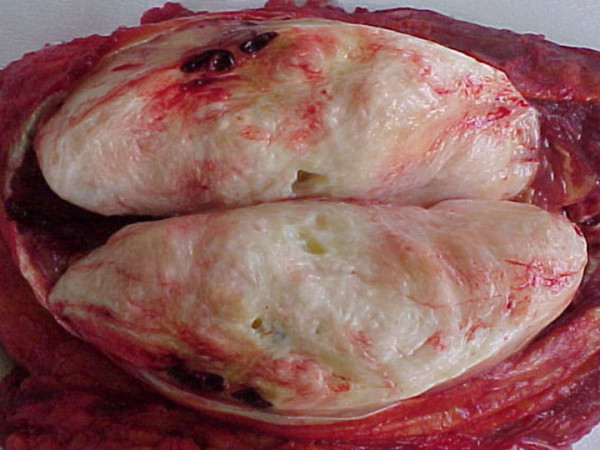
Photograph of the gross specimen excised shows a compact fibrous and lobulated soft tissue tumour.